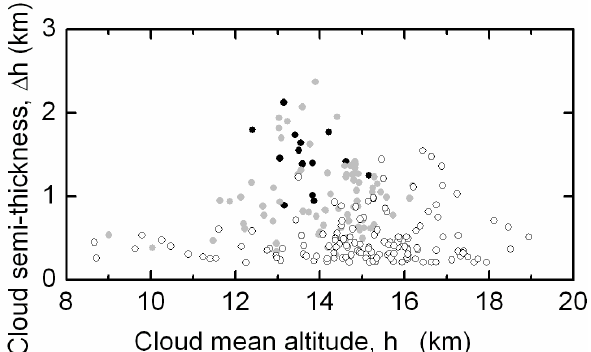
Fig. 10. Scatter plots showing the interdependence of cloud mean altitude ( h m ) and cloud semi-thickness ( 1h ) for tropical cirrus.